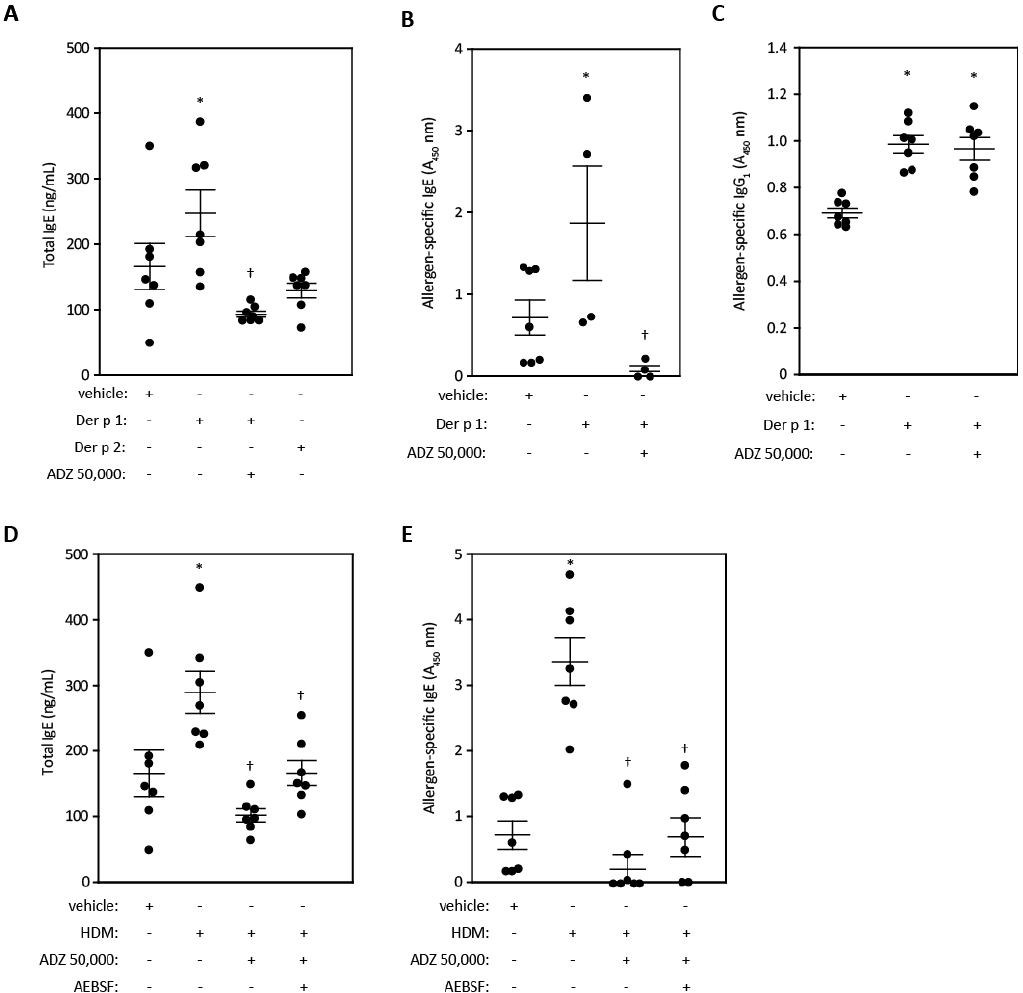
Figure 5. Prophylactic action of ADZ 50,000 against sensitisation to Der p 1 or an extract of mixed HDM allergens. ( A – C ). Serum concentrations of IgE, allergen-specific IgE and allergen-specific IgG 1 in Balb/c mice following intranasal immunisation (10 µL/head) with vehicle, Der p 1 or Der p 2 and the effect of ADZ 50,000 on responses to Der p 1. * p < 0.001–0.05 vs. control animals assigned to sham sensitisation. † p < 0.01 vs. animals sensitised with Der p 1 (5 µg/head). ( D , E ) Total and HDM allergen-specific serum IgE in Balb/c mice immunised intranasally with vehicle or mixed HDM allergens (normalised to 5 µg Der p 1) and the effect of co-administered ADZ 50,000 and AEBSF formulated in a 20:1 and 25:1 molar ratio to Der p 1 content. * p < 0.001–0.01 vs. control animals assigned to sham sensitisation. † p < 0.001–0.01 vs. animals sensitised with mixed HDM allergens. In all cases, data are shown as results for individual animals with mean ± s.e. indicated by cross-hair and whiskers.